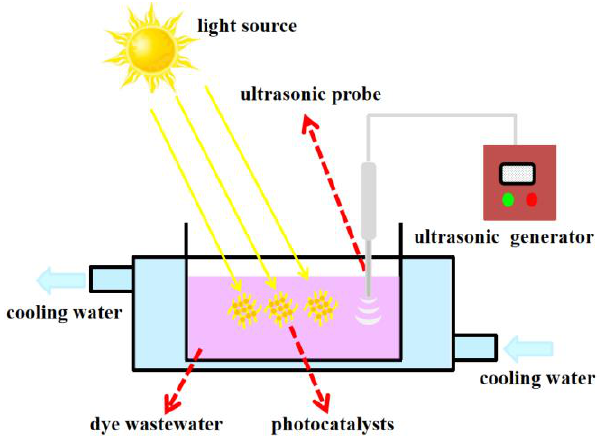
Figure 1. Schematic diagram of the sono-photocatalytic reactor.